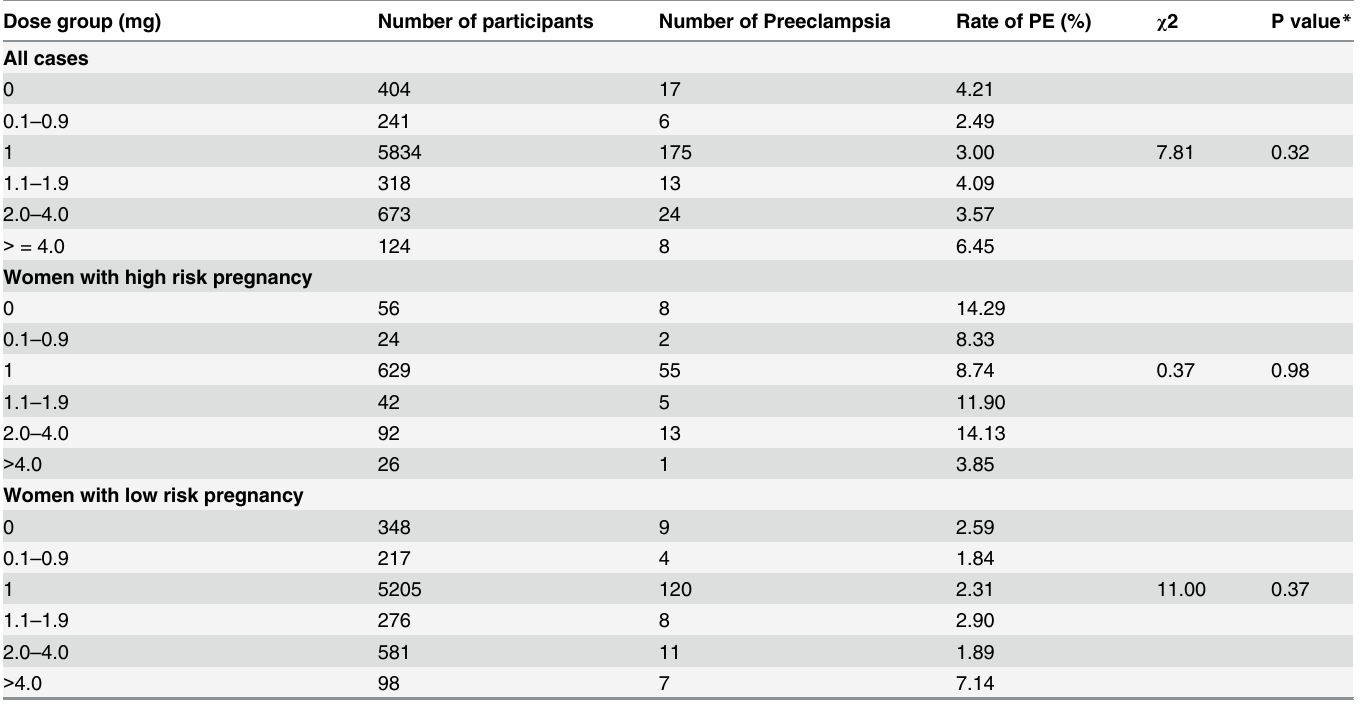
Table 5. Occurrences of PE according to folate dose groups.